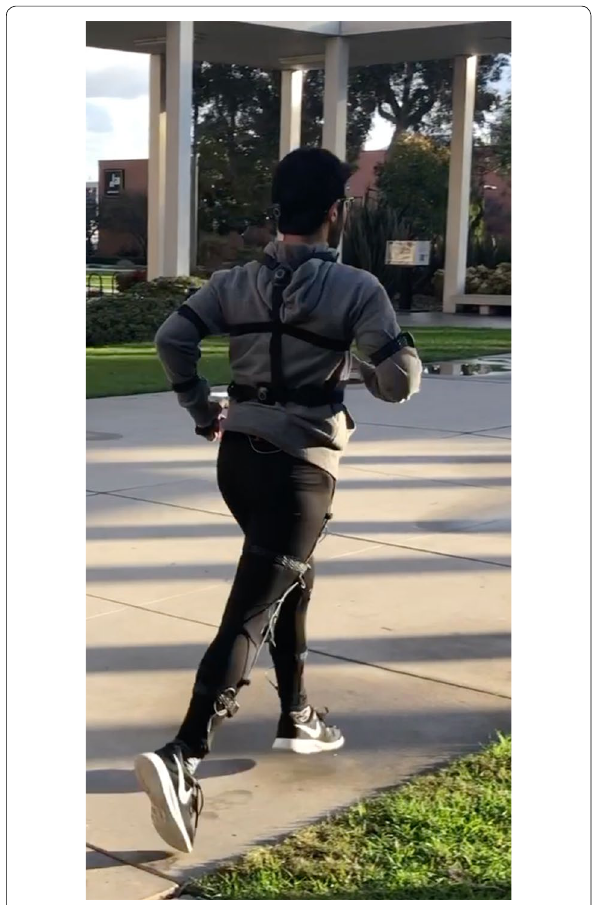
Fig. 2 Subject wearing the wireless sensing and feedback